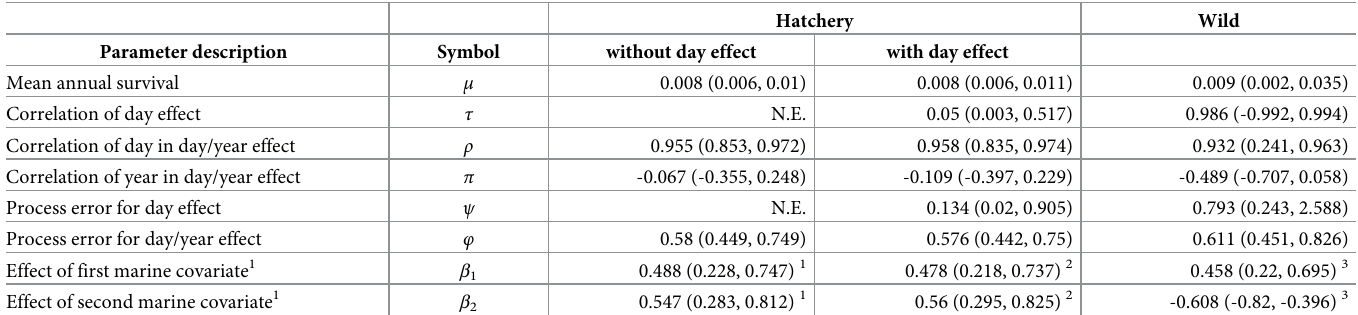
Table 5. Estimated models